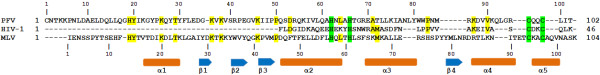
Sequence alignment of PFV, HIV-1 and Mo-MLV NTD-IN. The secondary structure of Mo-MLV is shown below. α-helices are marked as orange cylinders, and β-strands by blue arrows. Yellow boxes: at least two identical residues, Green boxes: three identical residues. Accession codes: PFV IN, CAA68999; HIV-1 IN, AAC83550 and Mo-MLV IN, P03355.